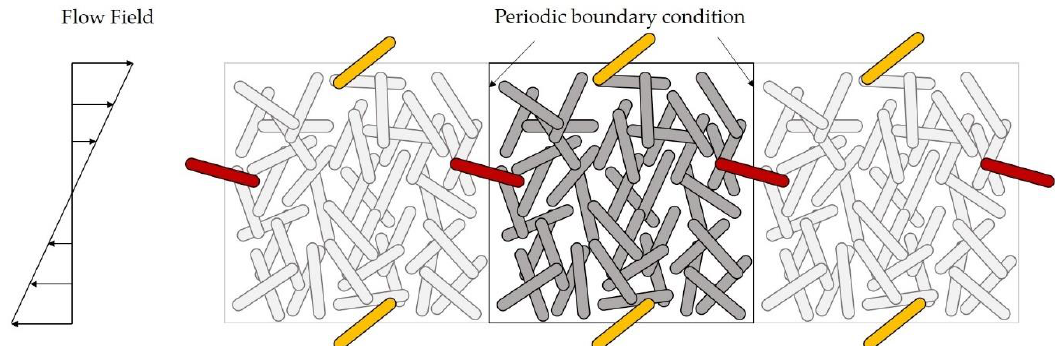
Figure 5. Shear cell with periodic boundary conditions. Table 1. Constant values of shear cell properties in simulation.